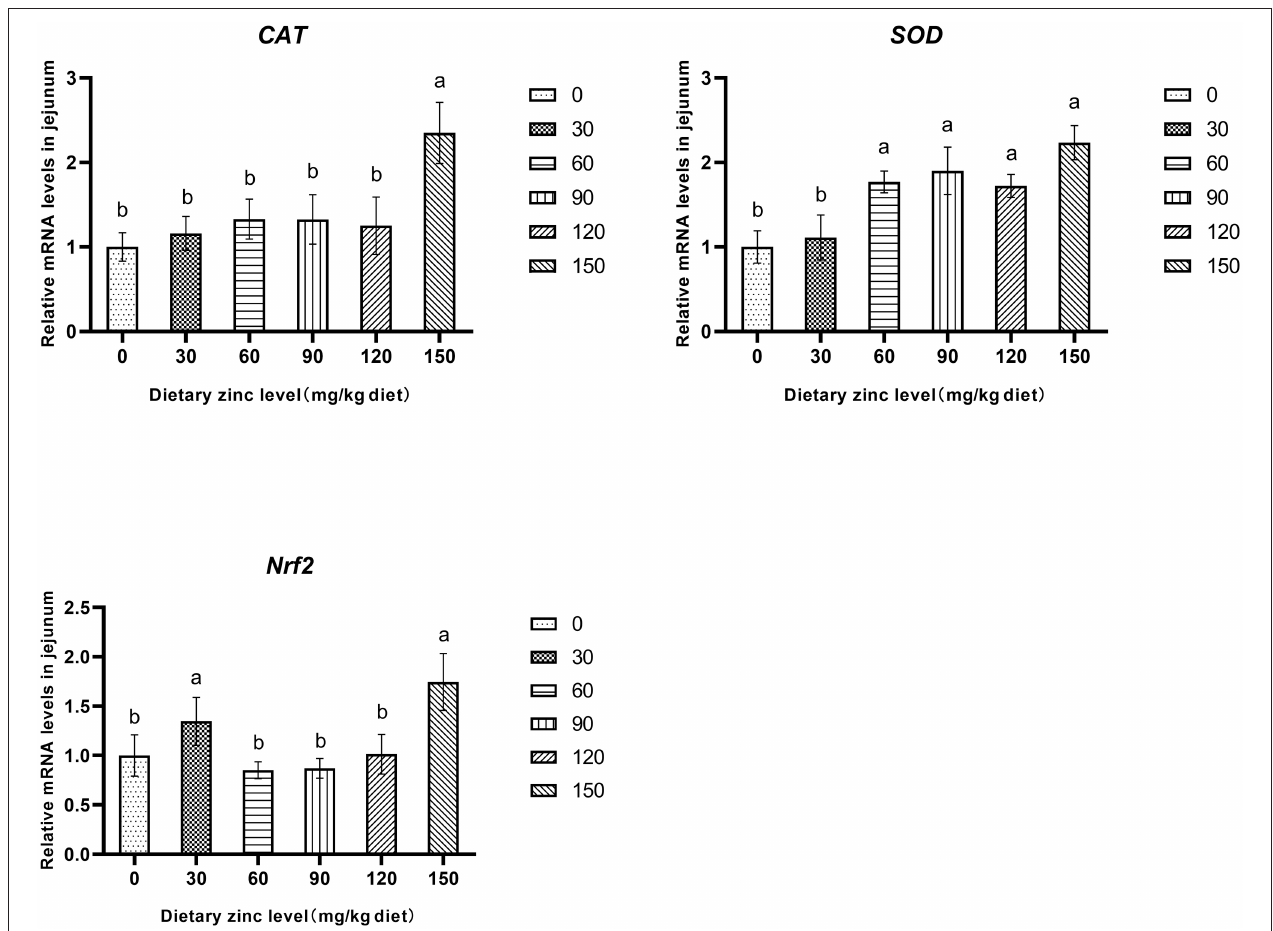
FIGURE 1 | Effects of Zn-Met on the gene expression of antioxidase activity in jejunum of ducks. CAT, catalase; SOD, superoxide dismutase; Nrf2, nuclear factor erythroid 2-related factor